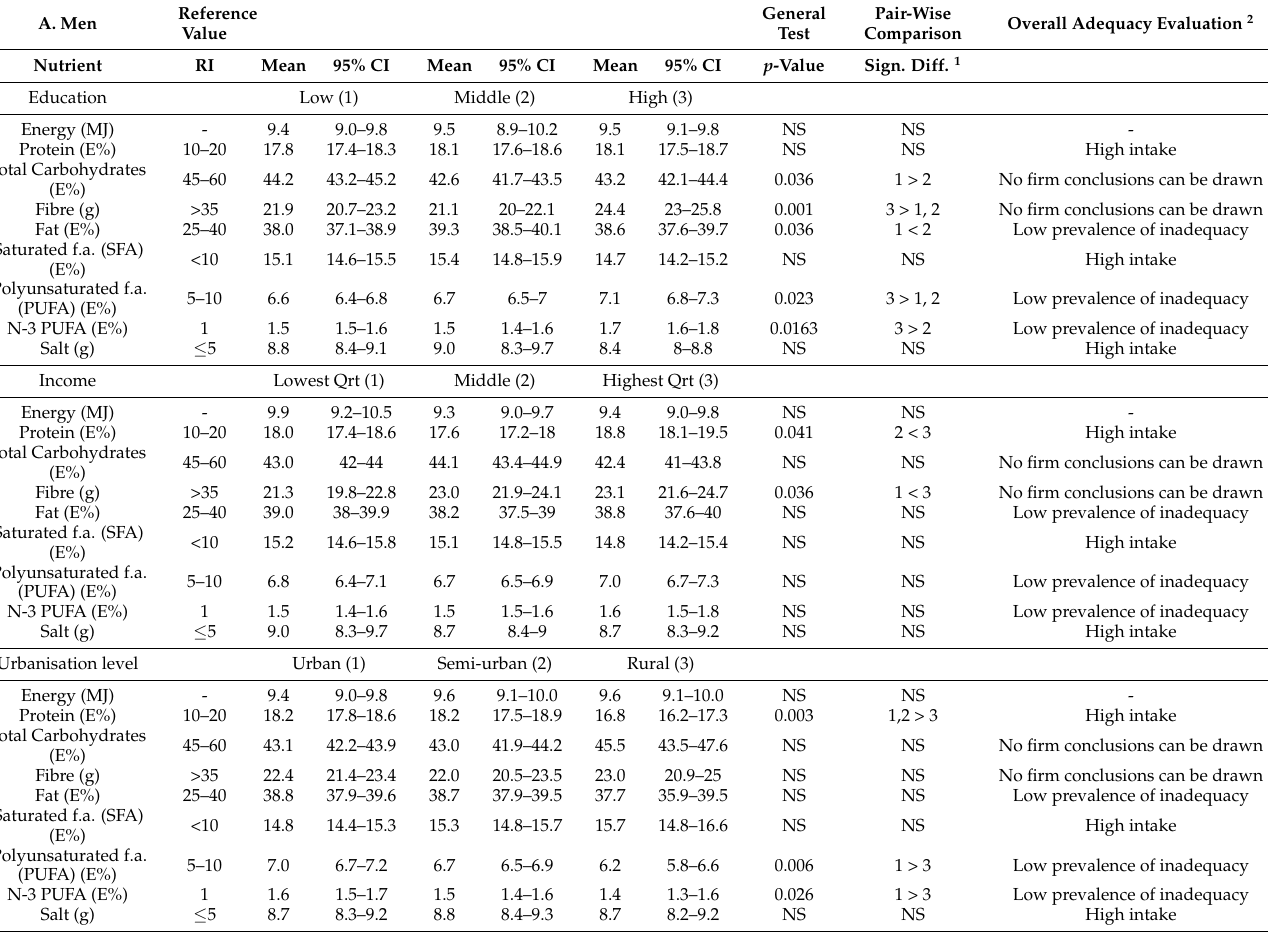
Table 3. Average nutrient intakes and adequacy evaluation based on recommended daily intake (RI) values in men and women by education, income and urbanisation